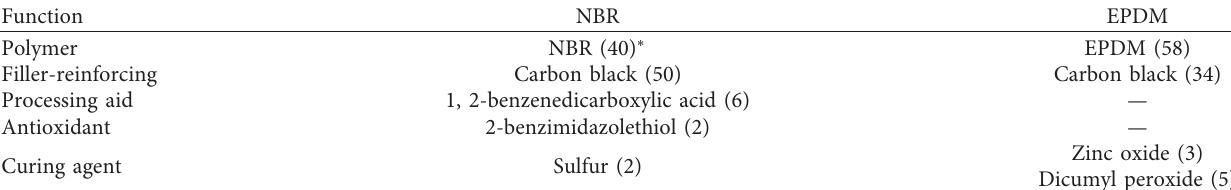
Table 1: Chemical compositions of NBR and EPDM specimens.